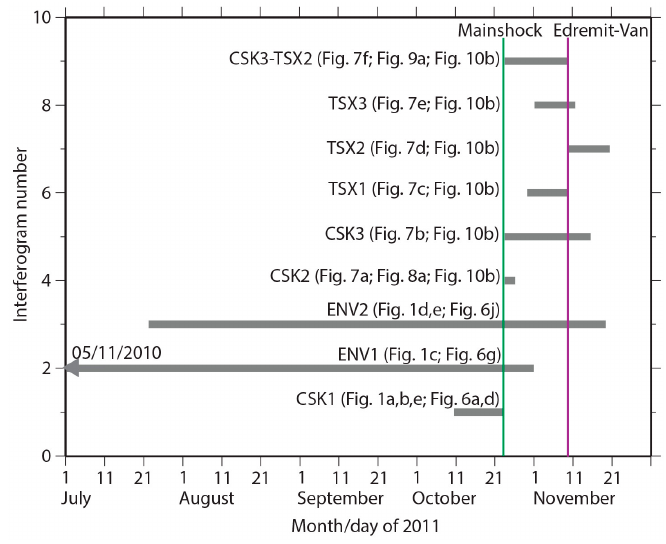
Figure 2. Graphical representation of the interferograms’ time span during the coseismic and post-seismic phases.